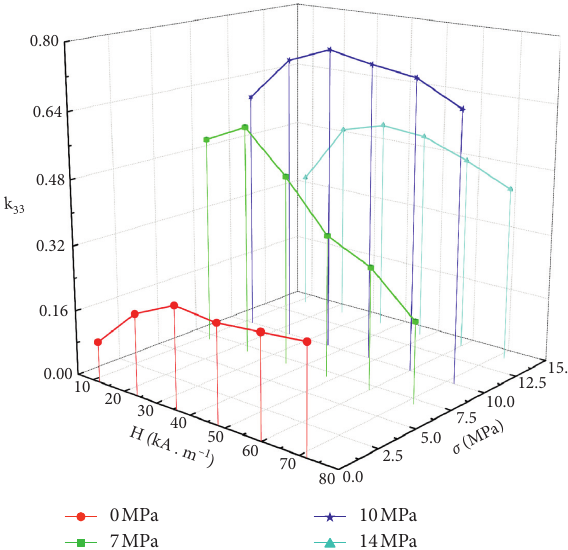
Figure 3: Relationship among pretightening stress, magnetic field strength, and electromechanical coupling